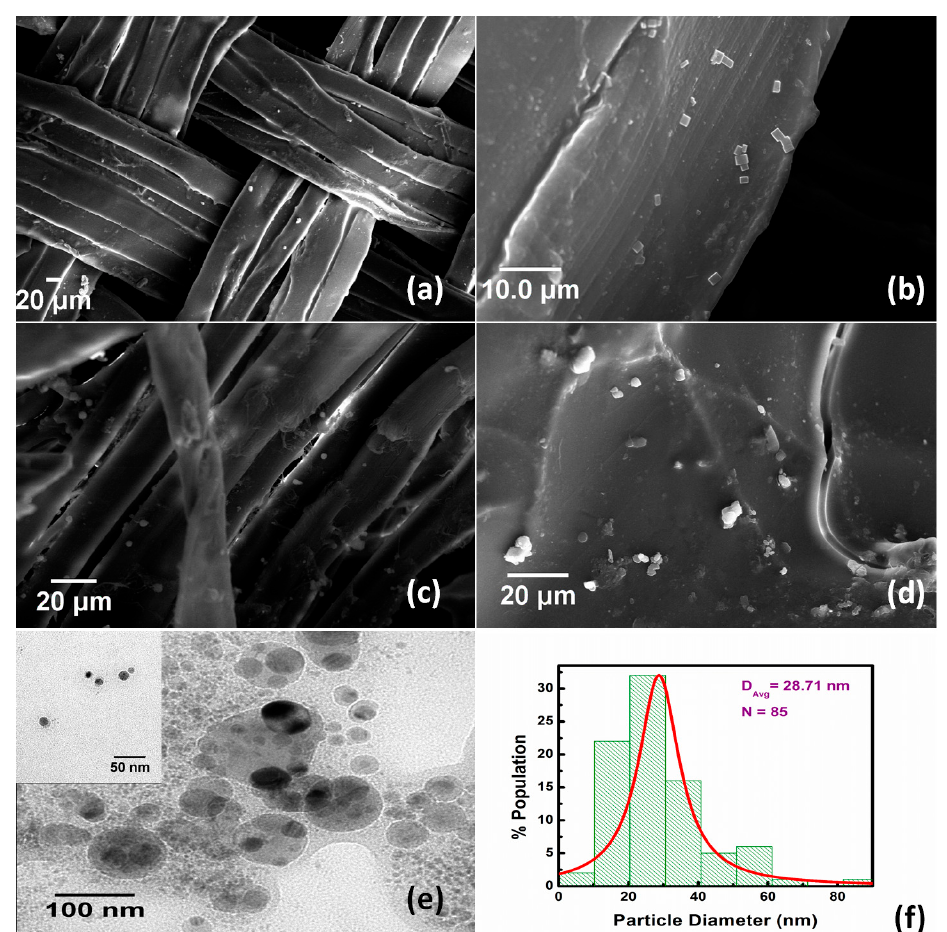
Figure 3. Scanning electron micrographs of ZnO deposited silk woven fabric ( a ), ( b ), ZnO deposited hydrogel coated silk woven fabric ( c ), ( d ). Transmission electrom micrograph of ZnO nanoparticles ( e ), and particle size distribution for ZnO nanoparticles ( f ).